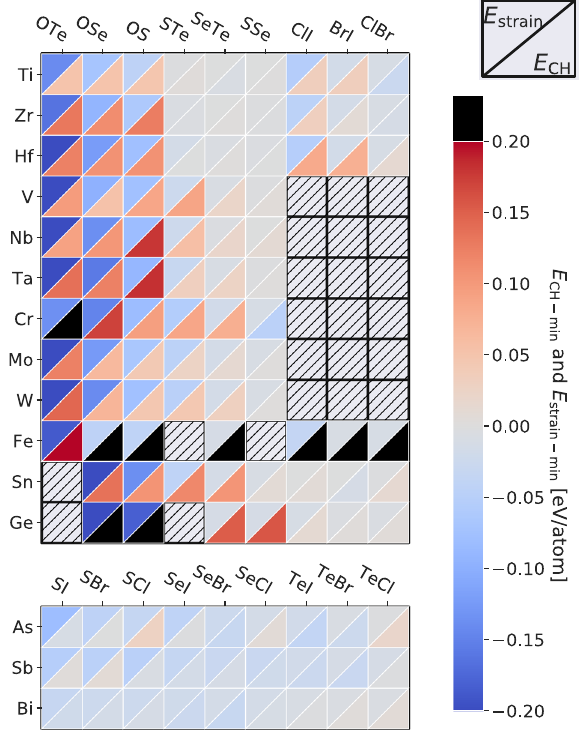
Fig. 4 Convex hull and tube strain energies at the optimal tube radius. The heatmap shows convex hull and tube strain energies at the optimal tube radius. Blue and bright colors indicate good stability, while a red color indicates poor stability. Values exceeding the metastability criterion of 0.2 eV/atom are shown in